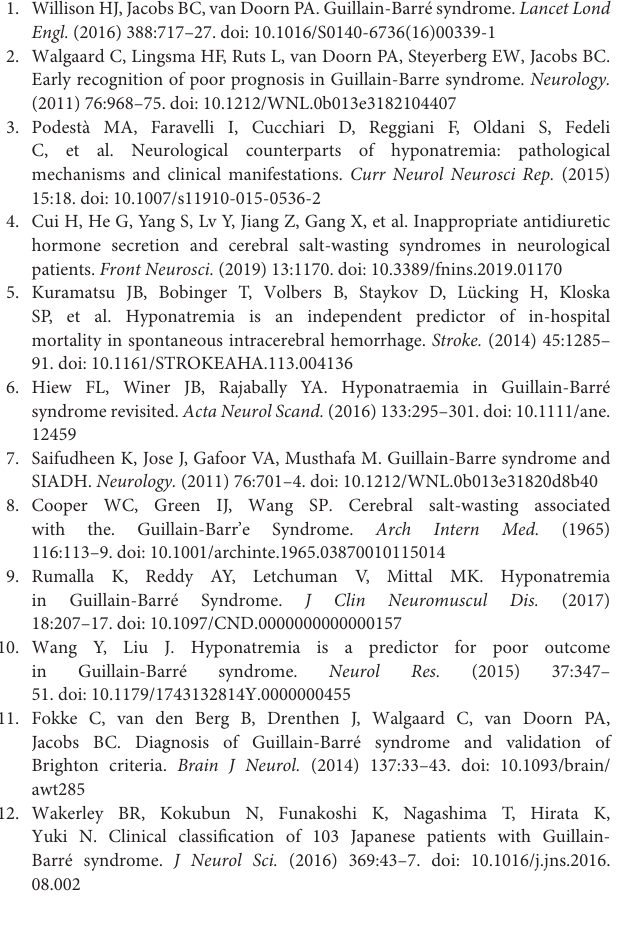
Supplementary Figure 1 | Exploratory analyses on the association between nadir sodium levels (mEq/L) during hospitalization and selected clinical features. The correlation between nadir sodium and continuous variables (baseline sodium and age) was summarized with the Spearman coefficient, while differences in nadir sodium levels among the strata of categorical variables (sex and IVIG) were assessed with the Mann-Whitney U-test. Supplementary Table 1 | Association between the occurrence of hyponatremia during hospitalization and clinical features. Univariable and multivariable